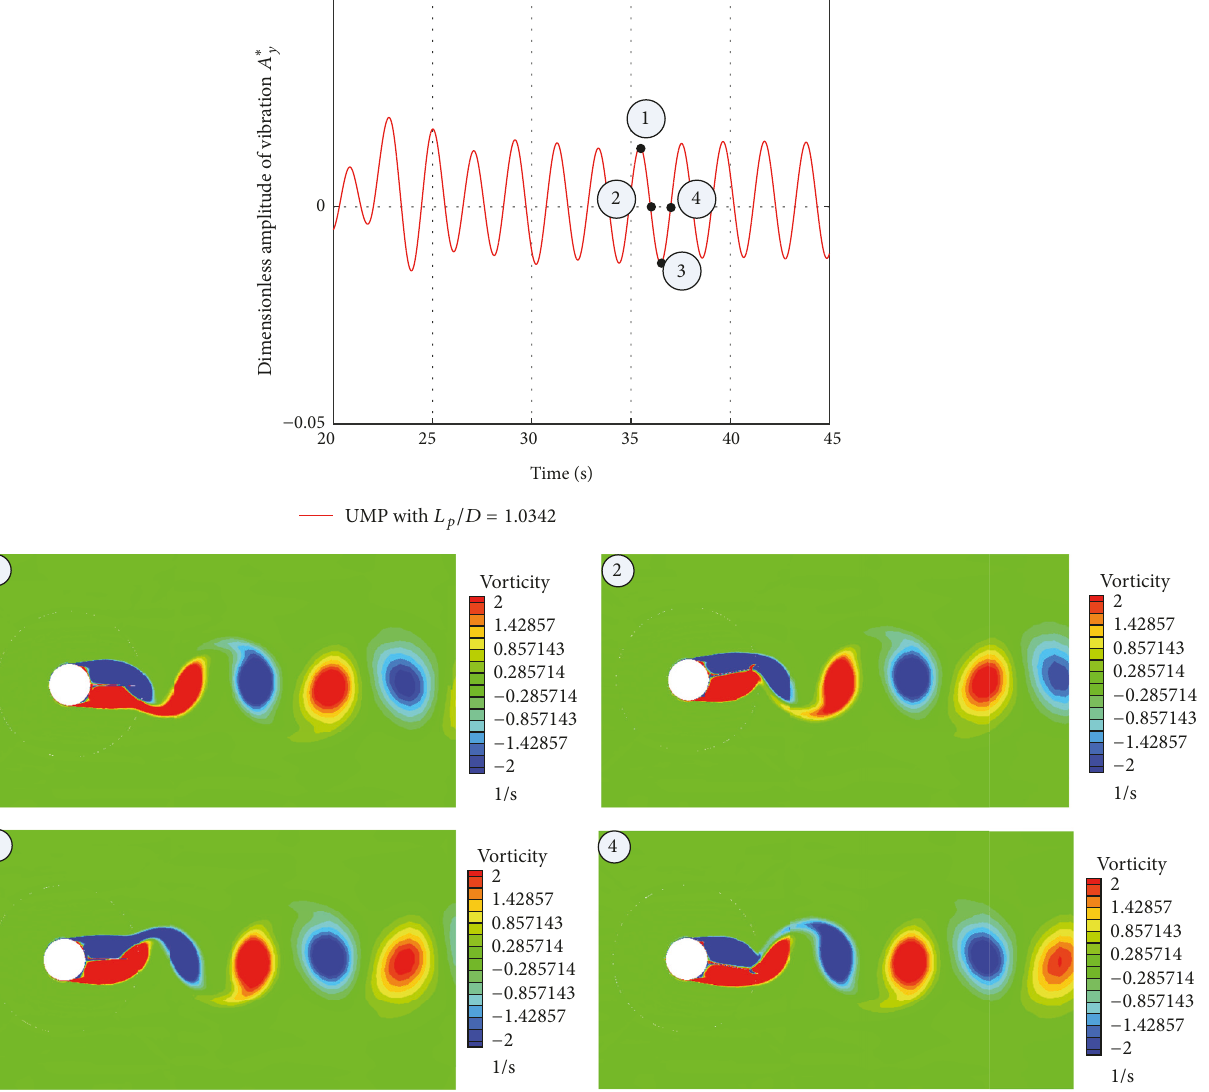
Figure 25: The vorticity cloud images of UPM with 𝐿 𝑝 /𝐷 = 1.0342